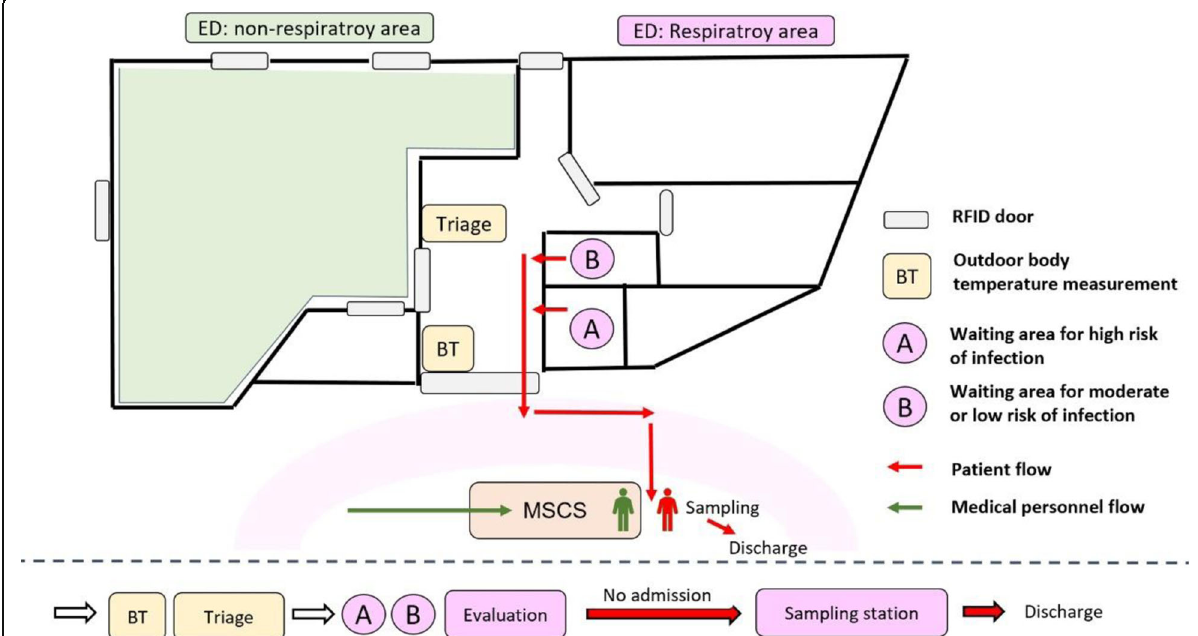
Fig. 1 Workflow of patients and medical personnel when using a multifunctional sample collection station (MSCS). RFID, radio-frequency identification